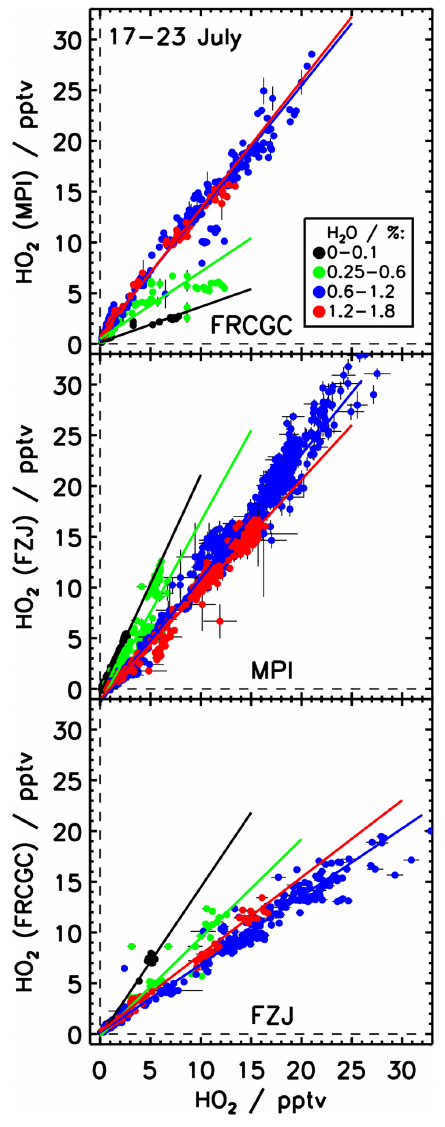
Fig. 11. Correlation of HO 2 mixing ratios classified for different water vapor mixing ratios in SAPHIR. All data are included with the exception of data during periods with ozone mixing ratios greater than 30ppbv in the dark chamber on 18, 19, 20, 23 July. Separate regression analysis were performed for each level of water concen- tration indicated by the different colors. Solid lines are results from a linear